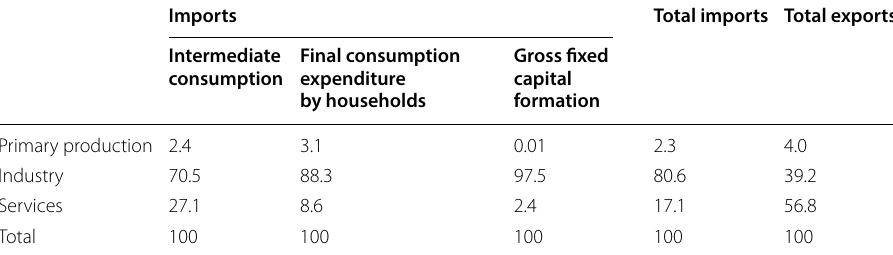
Table 3 Sectoral compositions (%) of imports and exports;